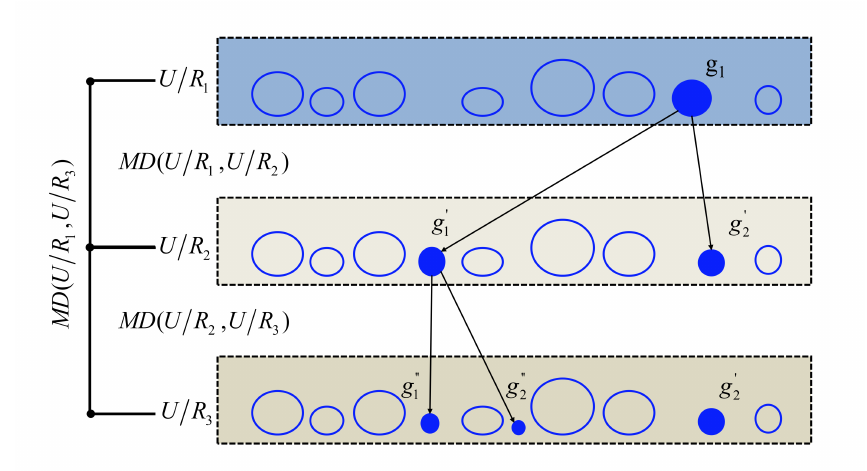
Figure 2. The relationship of MD among three granular